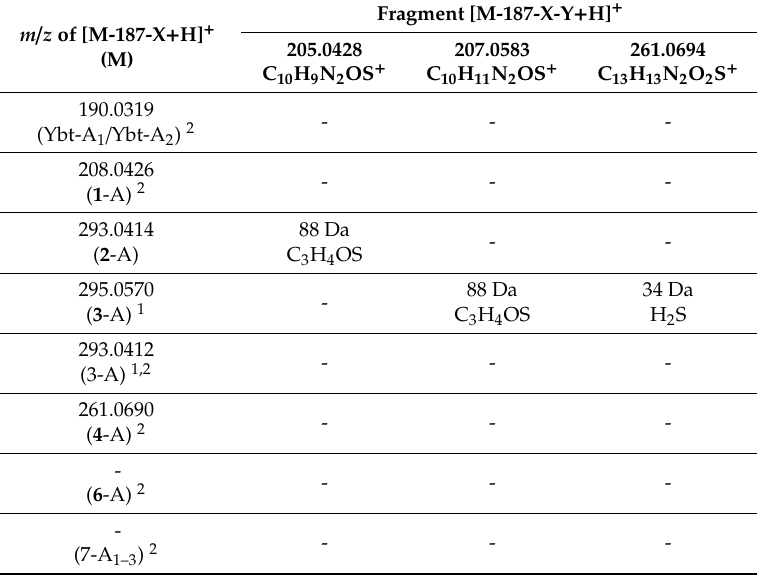
Table 8. Selected fragments caused by di ff erent NLs recorded during MS 4 experiments of Ybt and its novel derivatives by application of LC-HRMS. All recorded fragmentation spectra are shown in the Supplementary Material. The specific NLs [X] refer to the NLs shown in Tables 5 and 6. These NLs combined with the specific NLs [Y] listed in this table lead to the fragment ions [M-187-X-Y + H] + listed on top of the